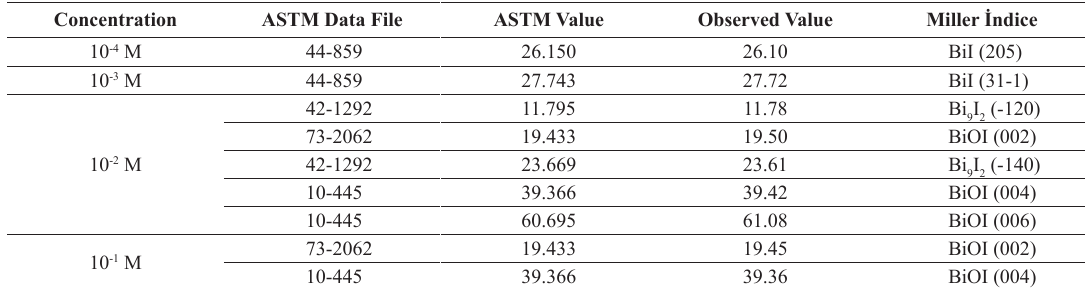
Table 1. XRD datas of ASTM values versus films Concentration ASTM Data